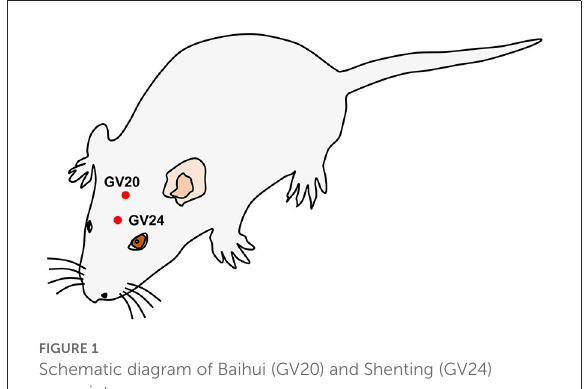
FIGURE1 Schematic diagram of Baihui (GV20) and Shenting (GV24) acupoints.